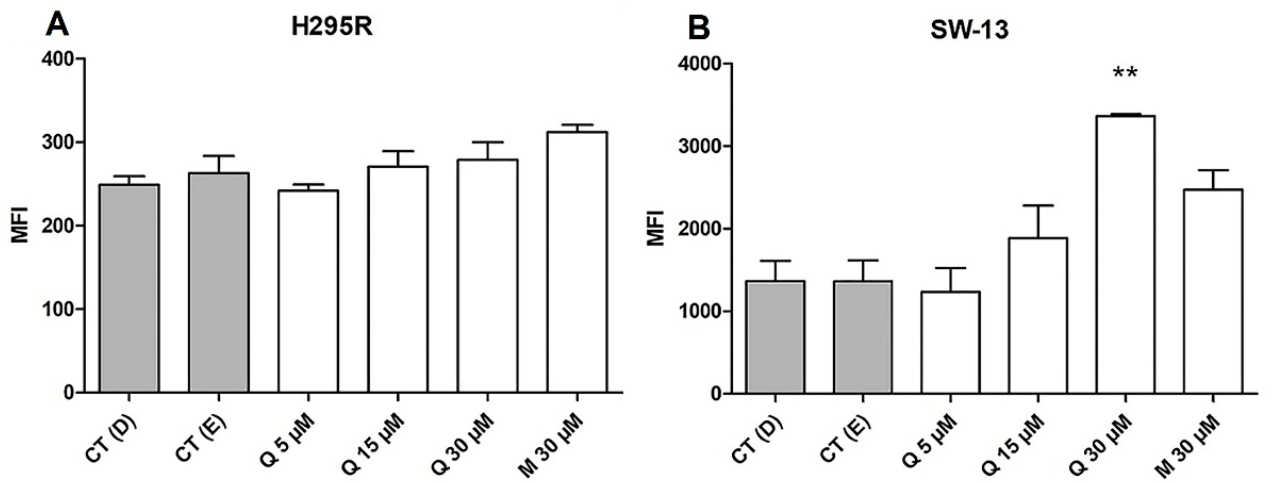
Figure 7. Quercetin and mitotane exerts distinct effects upon intracellular calcium rates. ( A ) Median of fluorescence intensity (MFI) of Fluo-3 AM on H295R; ( B ) MFI of Fluo-3 AM on SW-13 cells. ** ( p < 0.005) in comparison with respective controls.